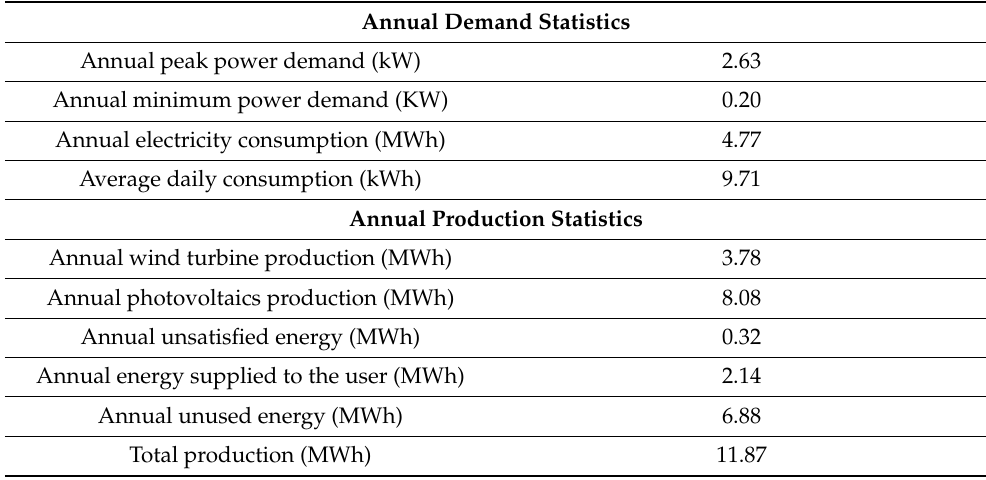
Table 3. Essential annual power demand and production statistics of the hybrid